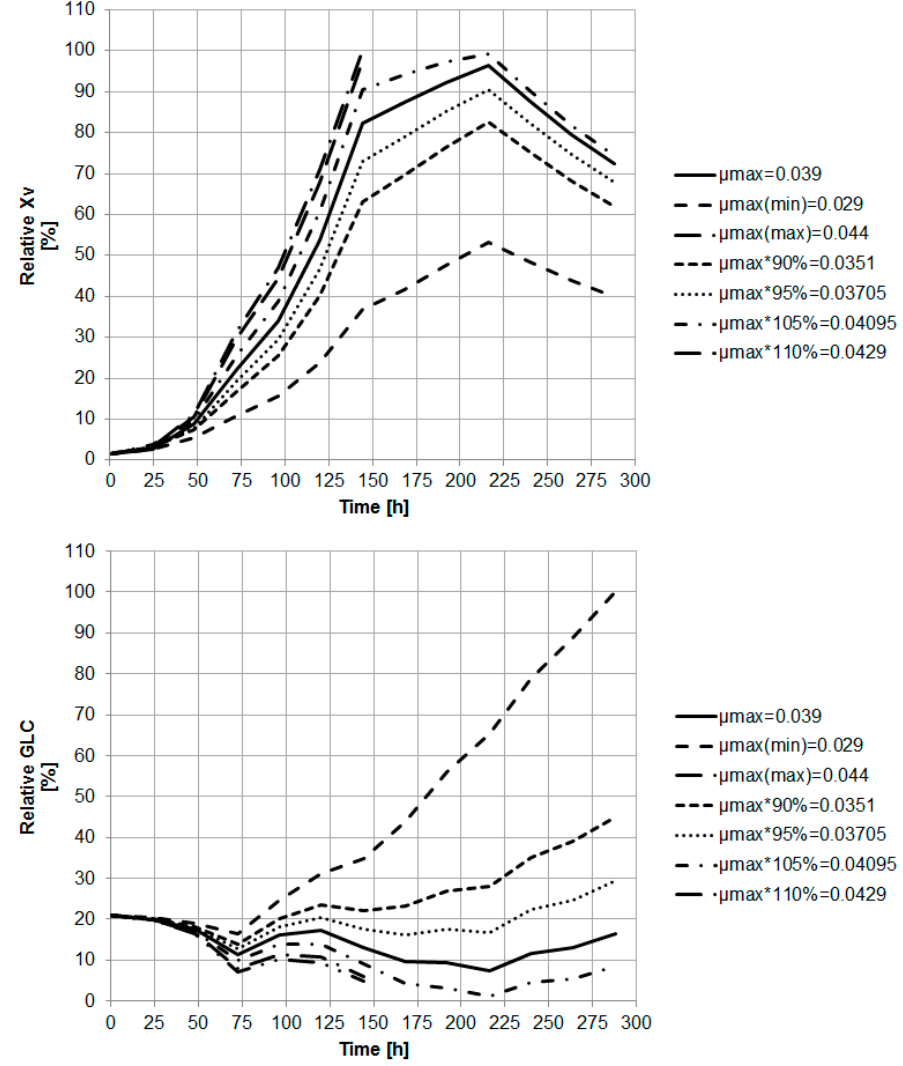
Figure 10. Influence of μ max on the viable cell and glucose concentration. μ max values represent data reported for mammalian cells (min, max), as well as ±5% and ±10% of the experimental determined value.